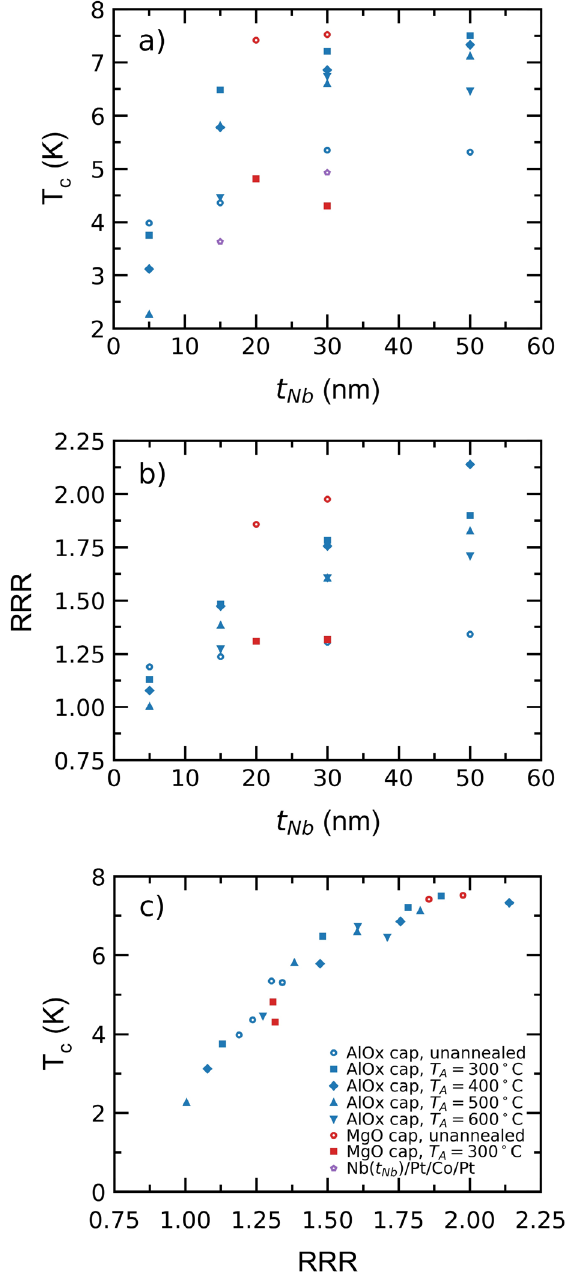
Figure 3. Data from transport measurements of Nb layers. Error bars are smaller than the symbol size. ( a ) T c as a function of Nb thickness, t Nb . Examples of T c for S-F heterostructures are shown in purple; ( b ) RRR as a function of t Nb . ( c ) T c as a function of RRR for all samples seen in (a) and